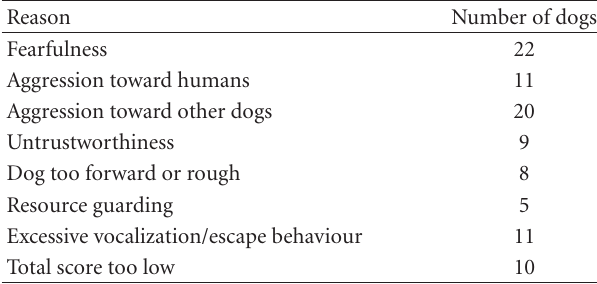
Table 2: Reasons given by assessors for failing dogs during the initial behaviour test (more than one reason was given for some